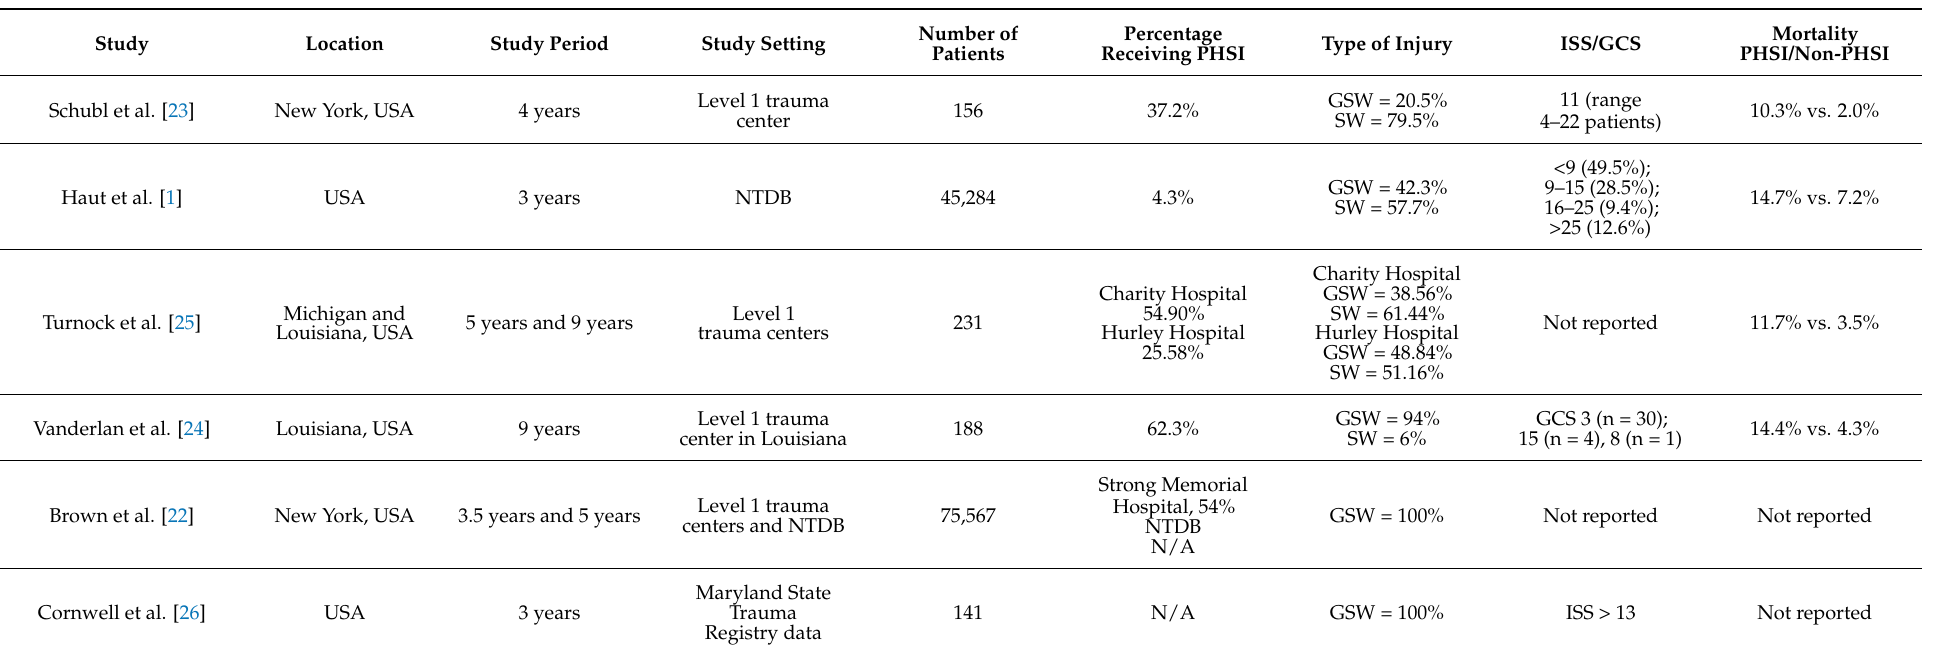
Table 1. Characteristics of included